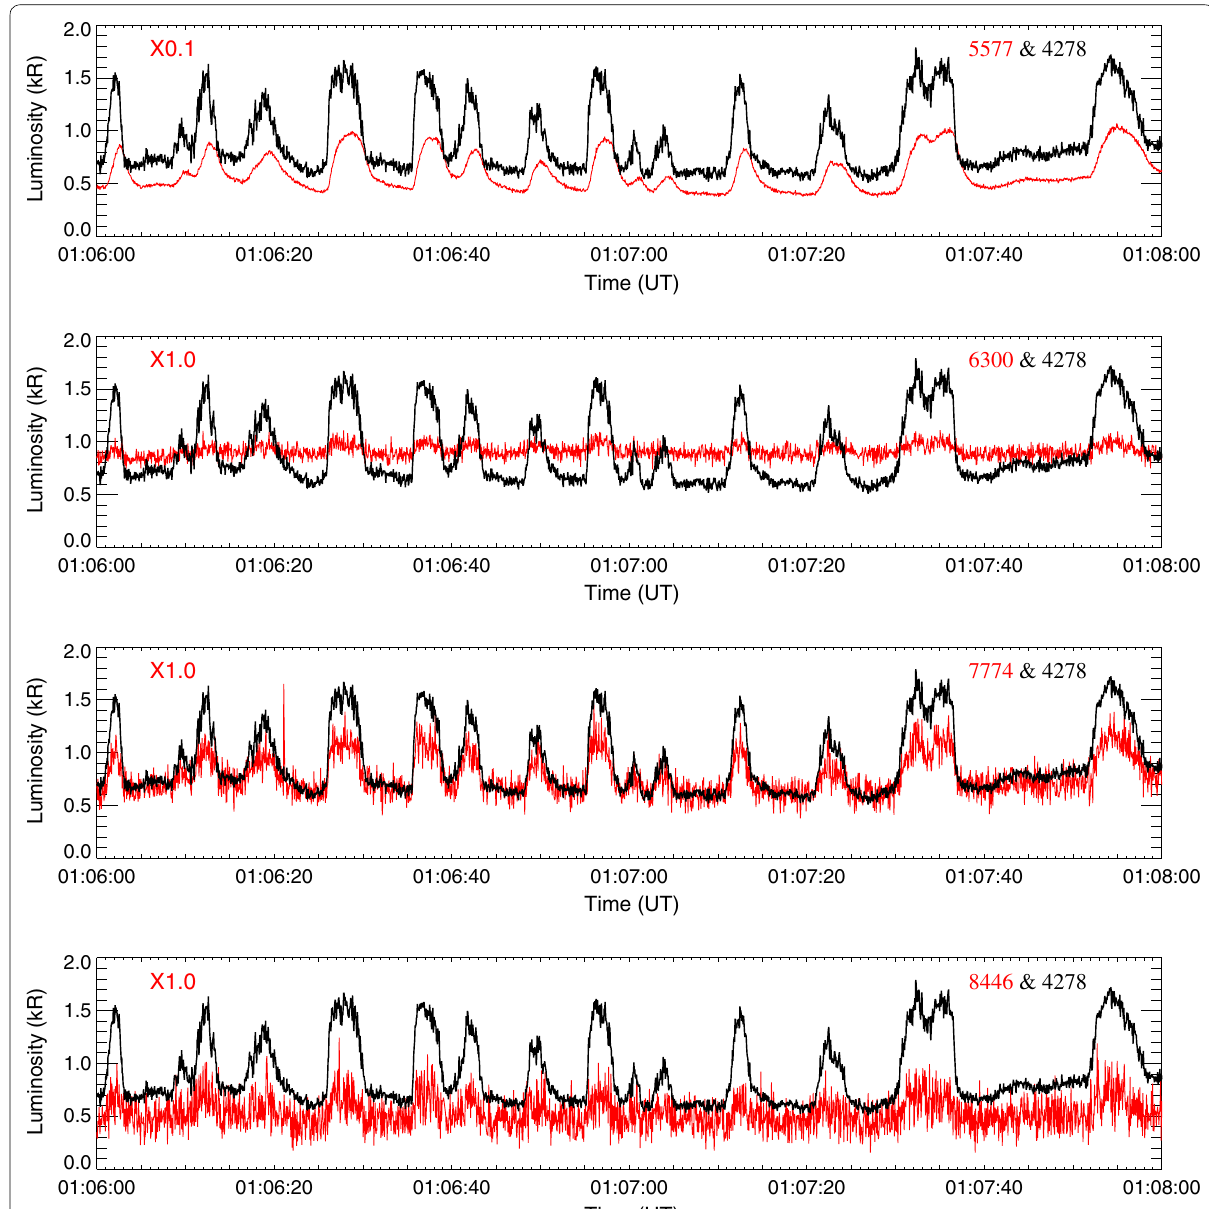
Fig. 10 This figure is the same as Fig. 7 except for the interval between 01:06:00 and 01:08:00 UT on October 20, 2017, and multiplied factors of 0.1, 1, 1, and 1 for the emissions of 557.7 nm, 630 nm, 777.4 nm, and 844.6 nm,